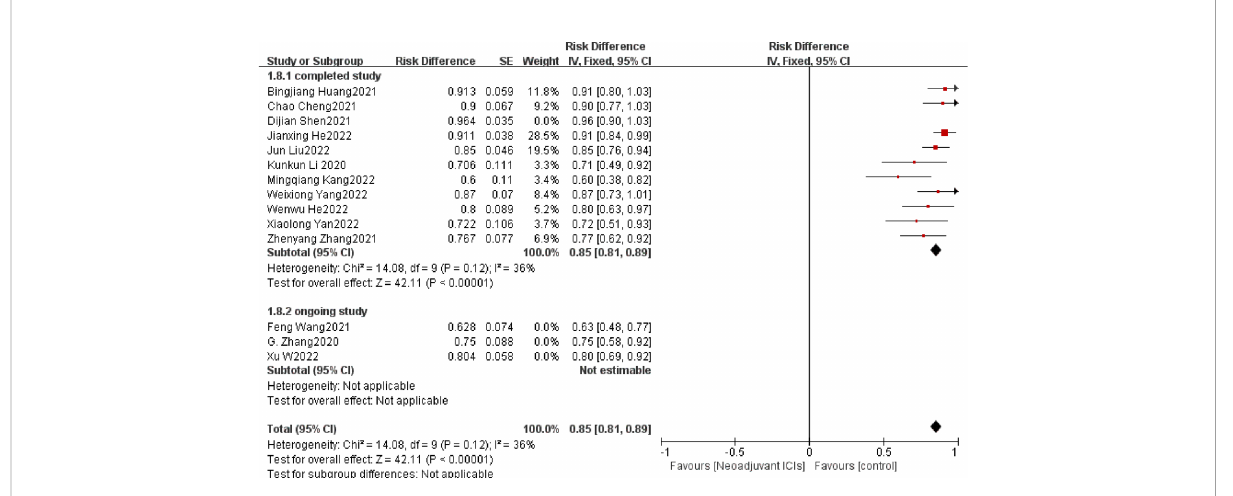
FIGURE 11 Sensitivity analysis was performed again after subgroup analysis of resection rate.